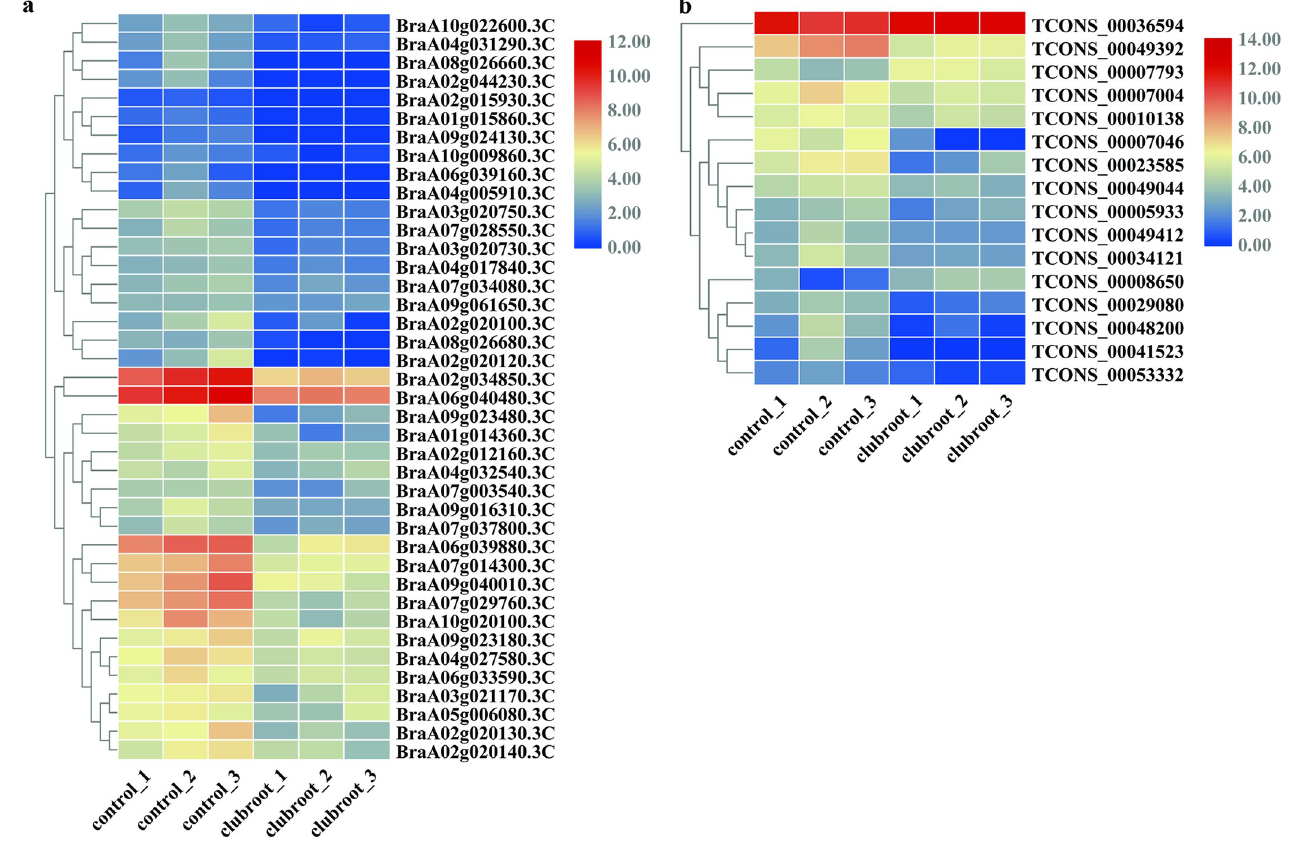
Fig 6. Expression levels of the 40 downregulated mRNAs (A) and 16 lncRNAs (B). https://doi.org/10.1371/journal.pone.0224927.g006 PLOS ONE | https://doi.org/10.1371/journal.pone.0224927 December5,